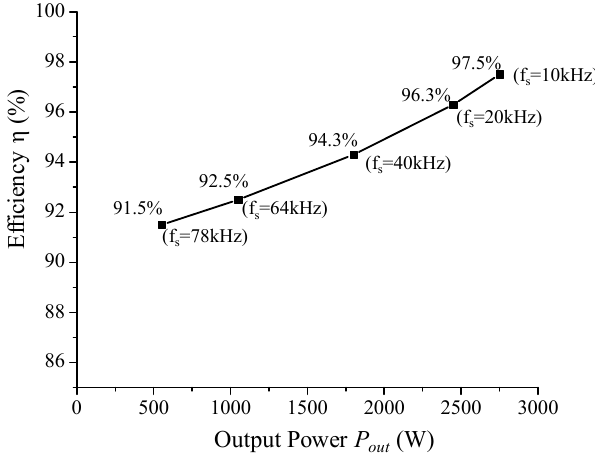
out versus switching frequency ratio f s / f o .